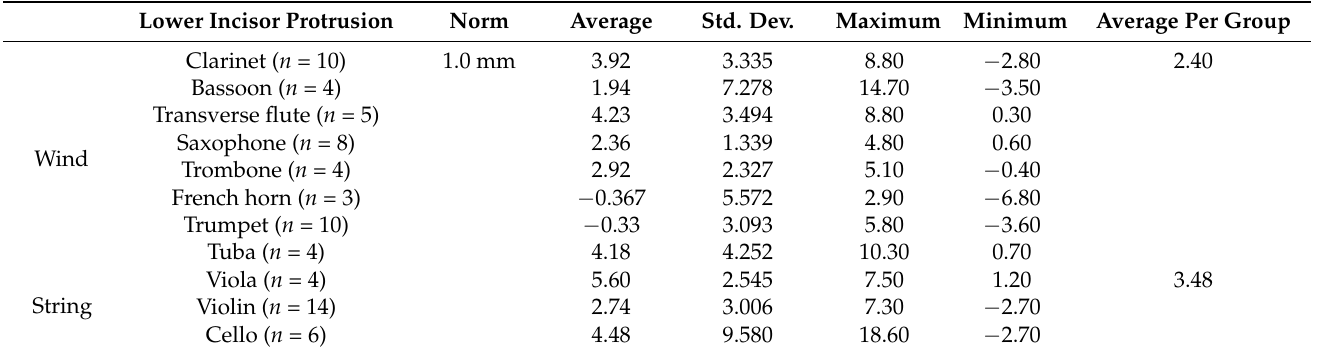
Table 6. Descriptive statistics for the variable lower incisor